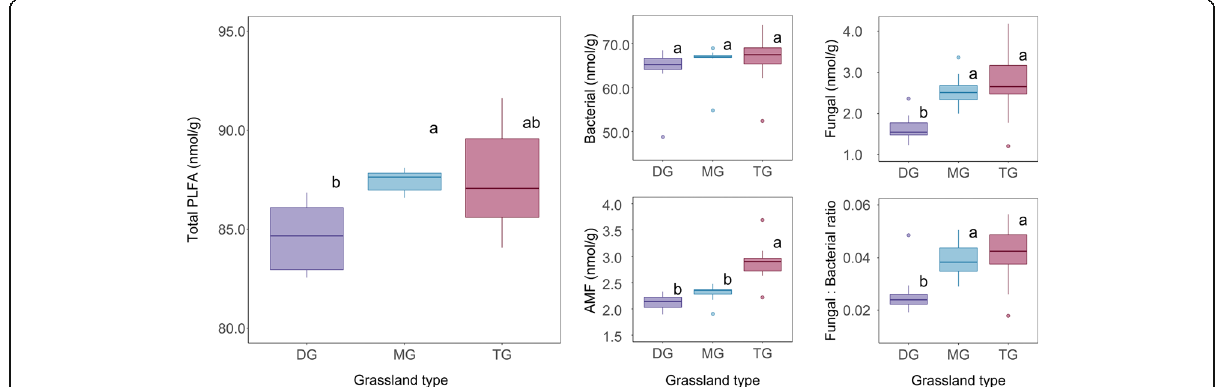
Fig. 2 Changes in soil microbial communities across the grassland degradation gradient. DG, degraded grassland; MG, meadow steppe; TG, grassland from the forest-steppe ecotone. Bars with different letters indicate significant difference at P < 0.05. Error bars represent ± SE